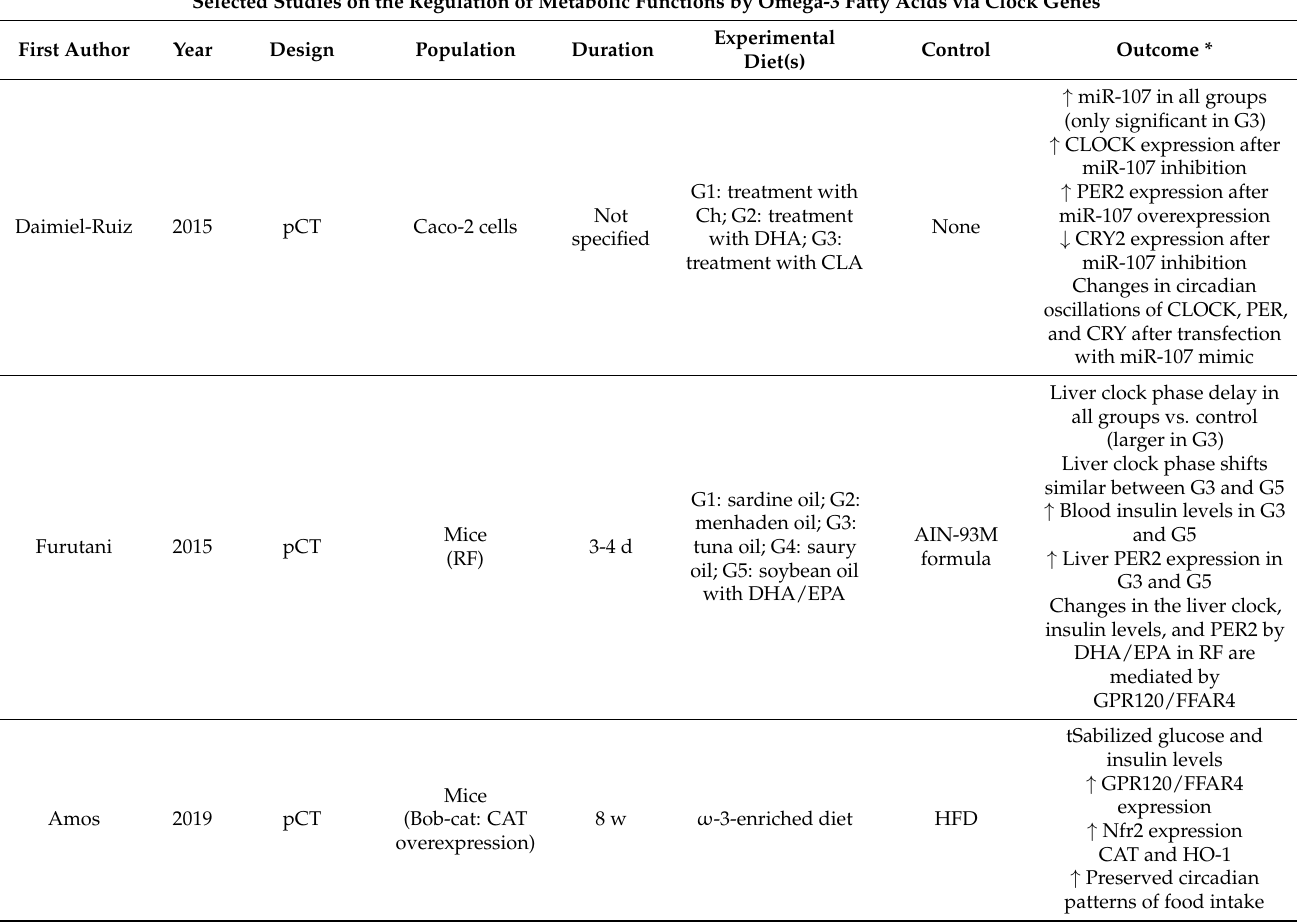
Table 4. Selected studies on the regulation of metabolic, reproductive, cardiovascular, and biochemical functions by omega-3 fatty acids via clock